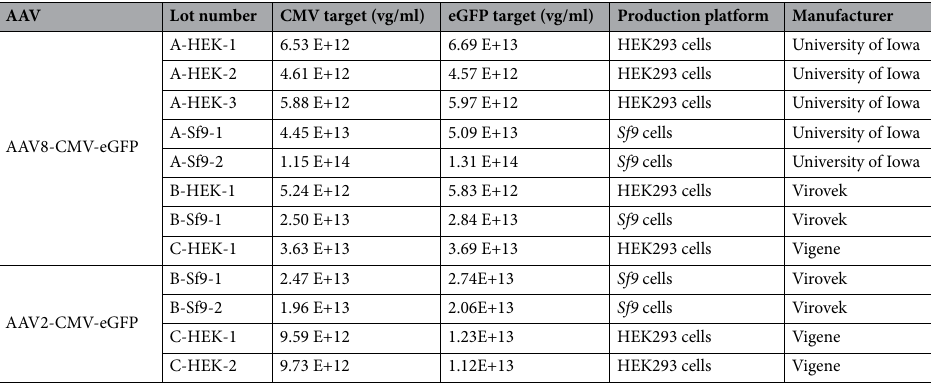
Table 1. Different lots of AAV8 and AAV2 viral vectors used in this